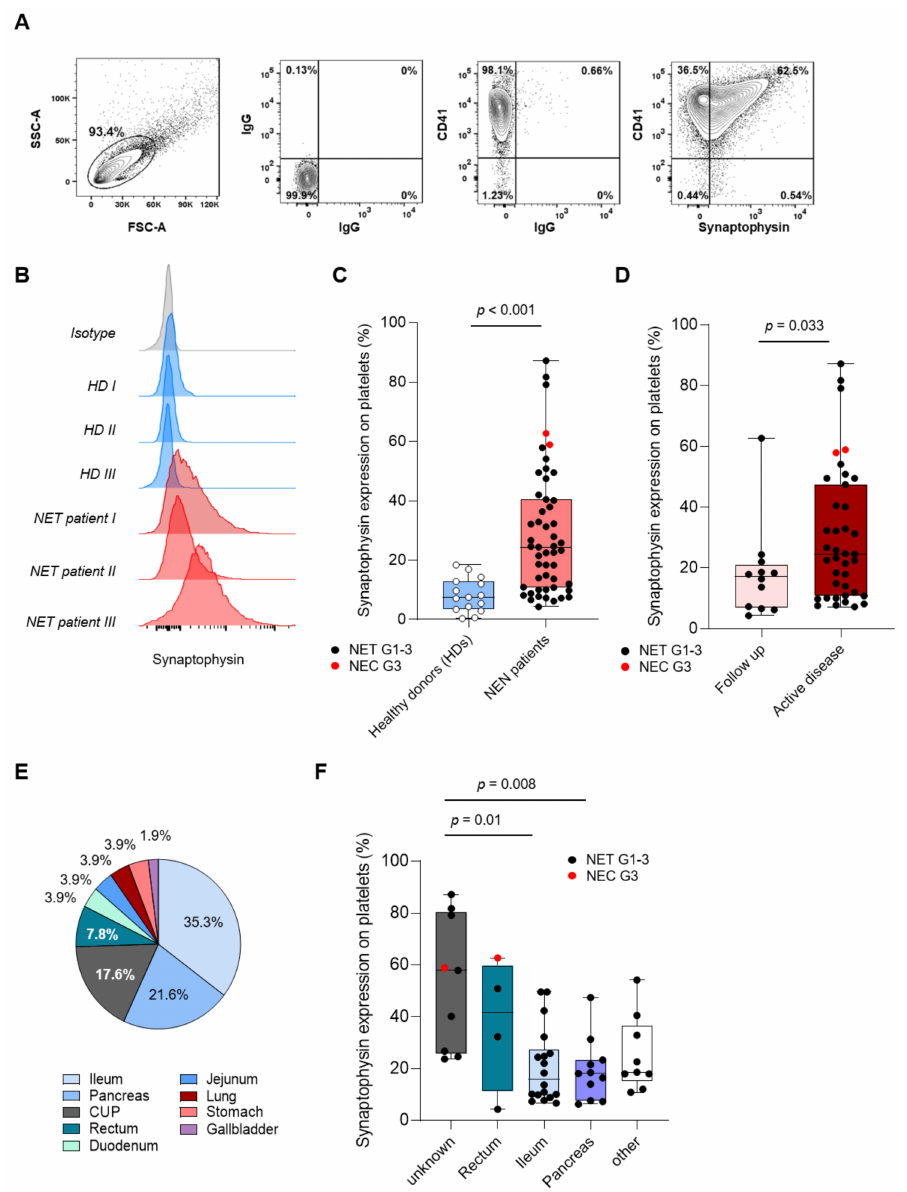
Figure 2. Characterization of pSyn in NEN patients and HD. ( A ) Gating strategy used to analyze pSyn expression on platelets ex vivo using flow cytometry. ( B ) Representative results for pSyn expression obtained from patients ( n = 3) and HDs ( n = 3) are shown. ( C ) pSyn expression of 20 HD and 51 NEN patients in the PoP cohort is shown. ( D ) pSyn expression levels in NEN patients receiving follow-up care and active disease. ( E ) Primary tumor origins of the NEN PoP cohort ( n = 51). ( F ) pSyn expression in accordance to primary tumor